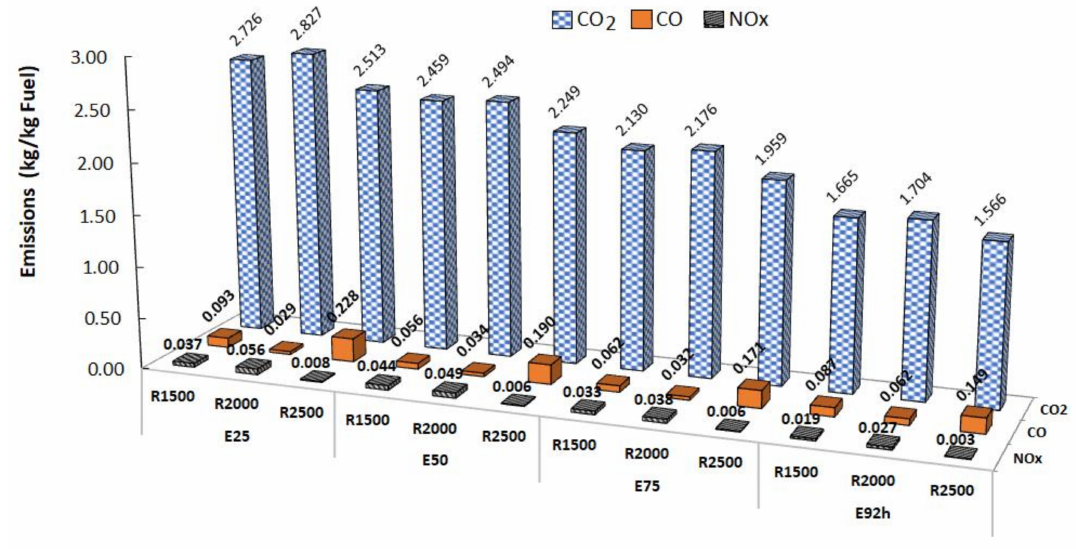
Figure 2. Emissions of pollutants vs. fuels and engine speeds.